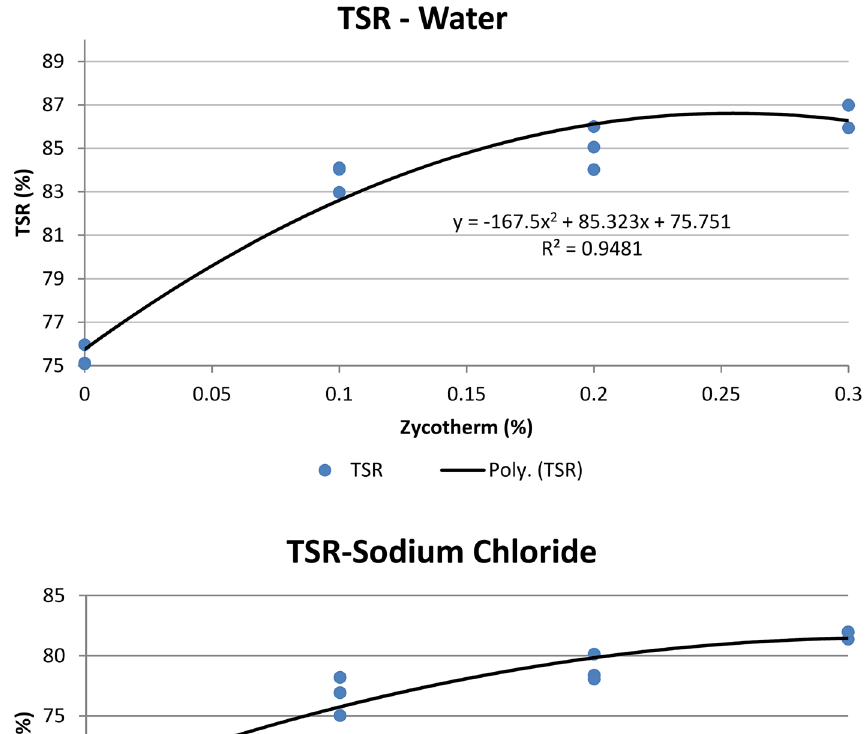
Fig. 10 Regression model of TSR for samples saturated with Water